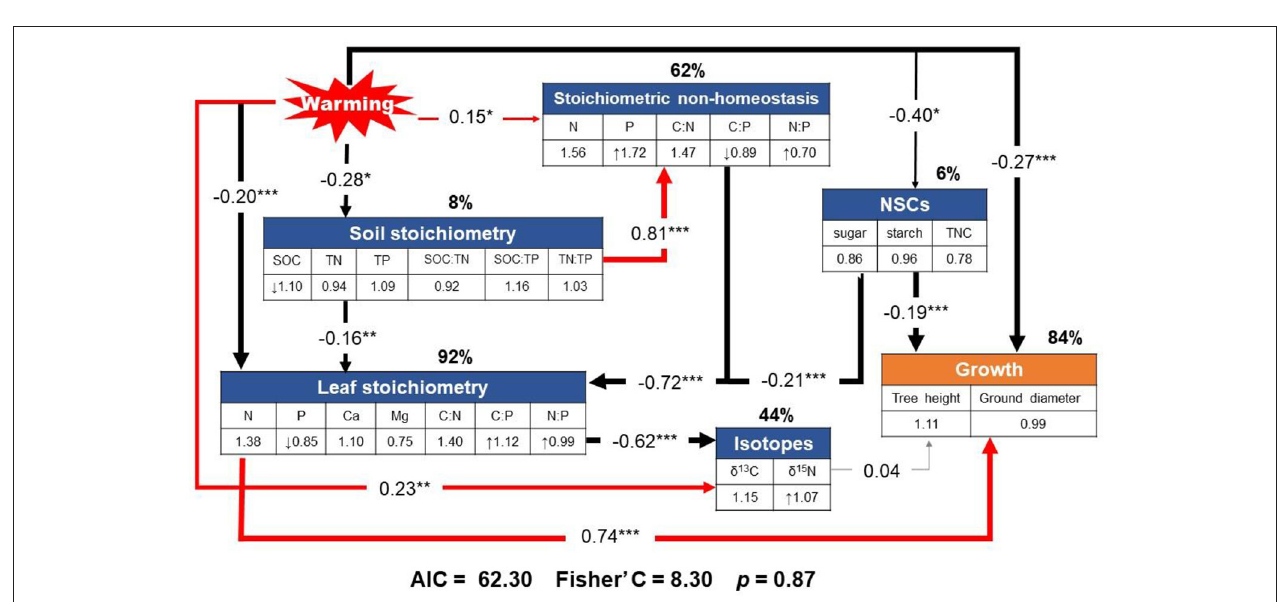
FIGURE 6 | Linear relationships between seasonal rainfall and response ratios of foliar N concentration (A) , C:N ratio (B) , N:Mg ratio (C) , and δ 15 N (D) ( n = 12). The response ratios were calculated as the ratios of foliar chemical properties under warming treatment to those under control treatment.